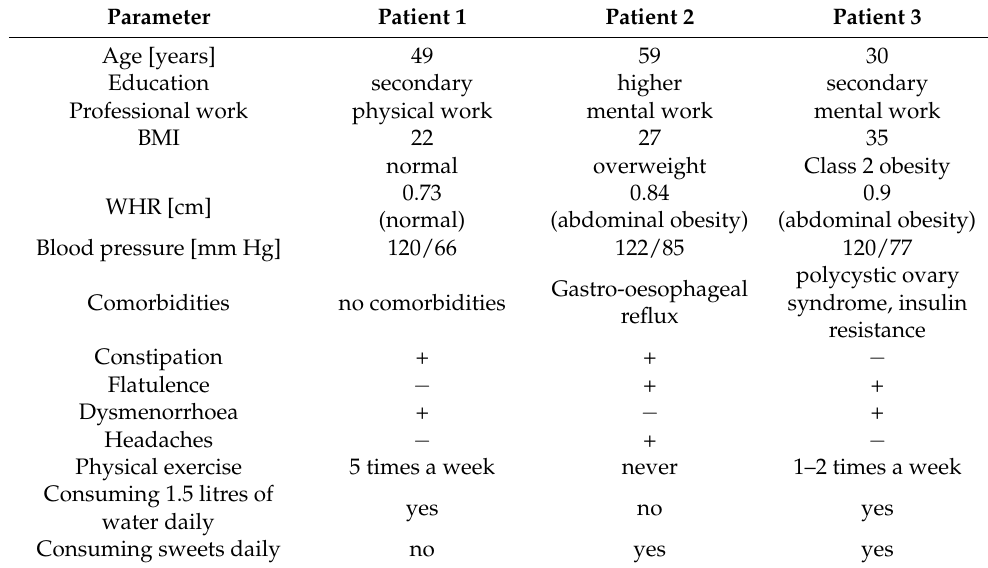
Table 1. Characteristics of the subjects with normal body weight, overweight, and class 2 obesity. Parameter Patient 1 Patient 2 Patient 3 Age